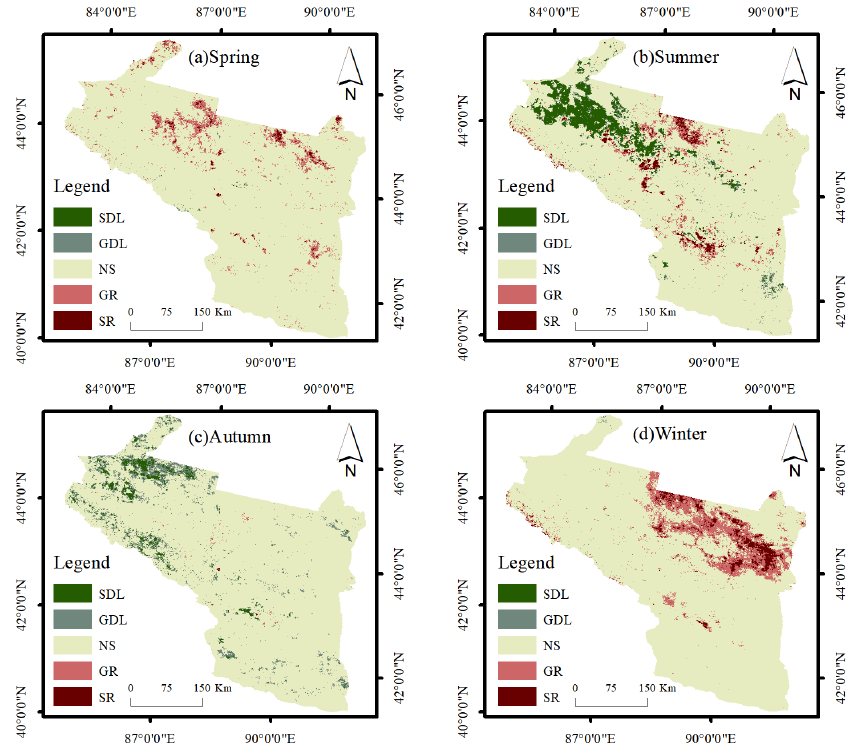
Figure 5. Average LST M – K test for 2003 to 2020.